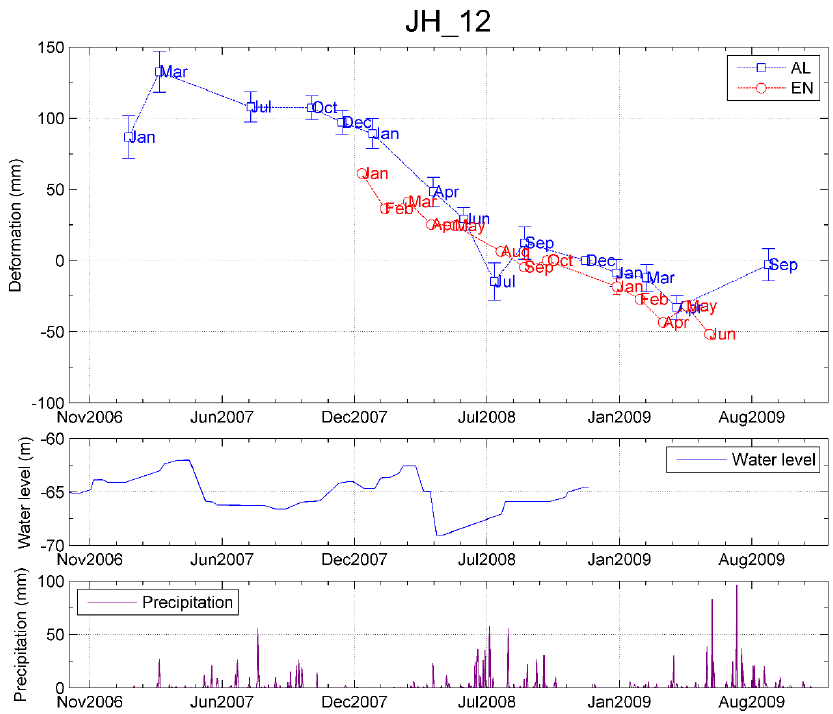
Figure 11. Envisat and ALOS LOS displacement at JH-12 Well (the triangle in Figure 12b) in east subsidence area. Precipitation data are available from China Meteorological Administration, specifically meteorology station No. 54527 in Tianjin [65]. Water level of JH-12 Well in Aquifer II is available to the end of 2008 [27].